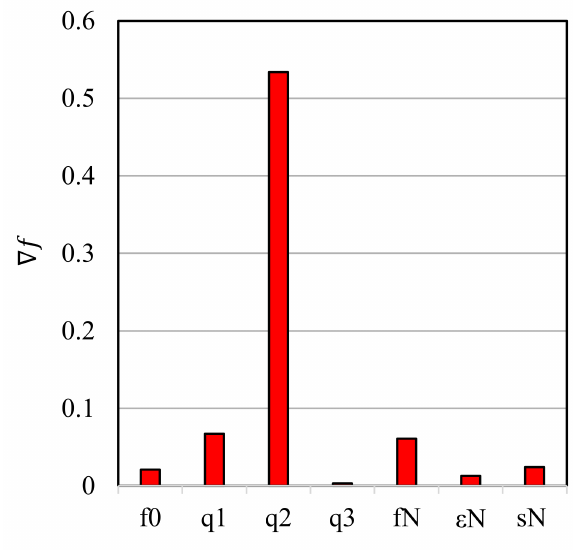
Figure 21. Sensitivity analysis carried out on the following parameters: f 0 = 0.01; q 1 = 1.5; q 2 = 1; q 3 = 1.5625; f N = 0.01; ε N = 0.25 and s N =